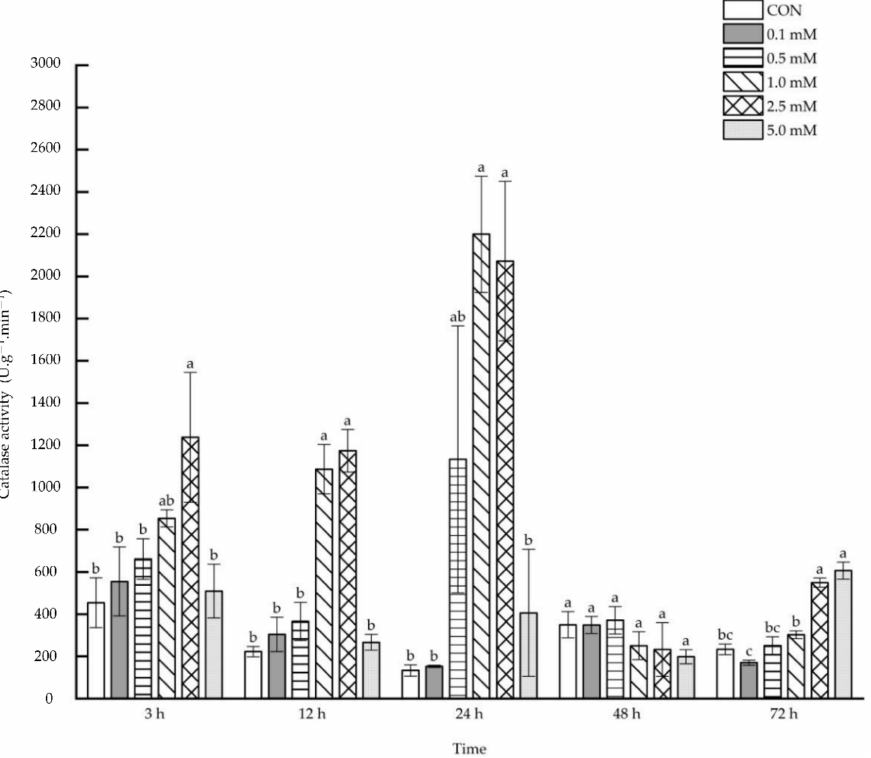
Figure 5. The direct effect of the SA concentration and post-treatment time on the catalase activity in leaves following exogenous foliar application. The data are presented as mean ± standard errors. The significance of data was determined by the Duncan method. The difference between different letters at the same time reached significant levels of